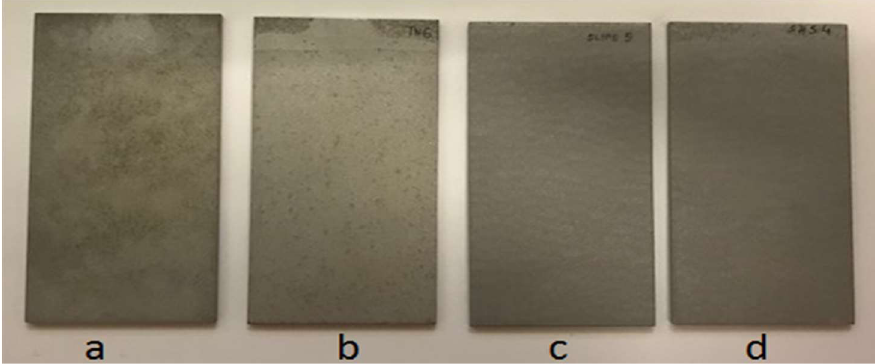
Figure 12. Dust deposition on uncoated ( a , b ) and coated ( c ), SLIPS; ( d ) LF aluminum substrates.